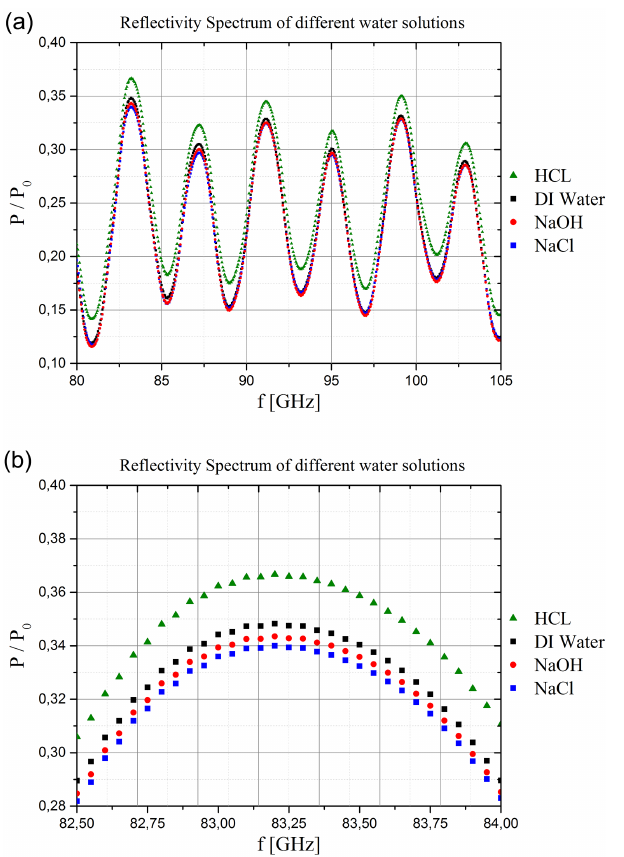
Figure 7. (a) Reflectivity spectrum of a HDPE cuvette filled with different solutions. (b) Error bars on the data points are much smaller than the markers used for visualization. Therefore, the dif- ferent solutions are clearly